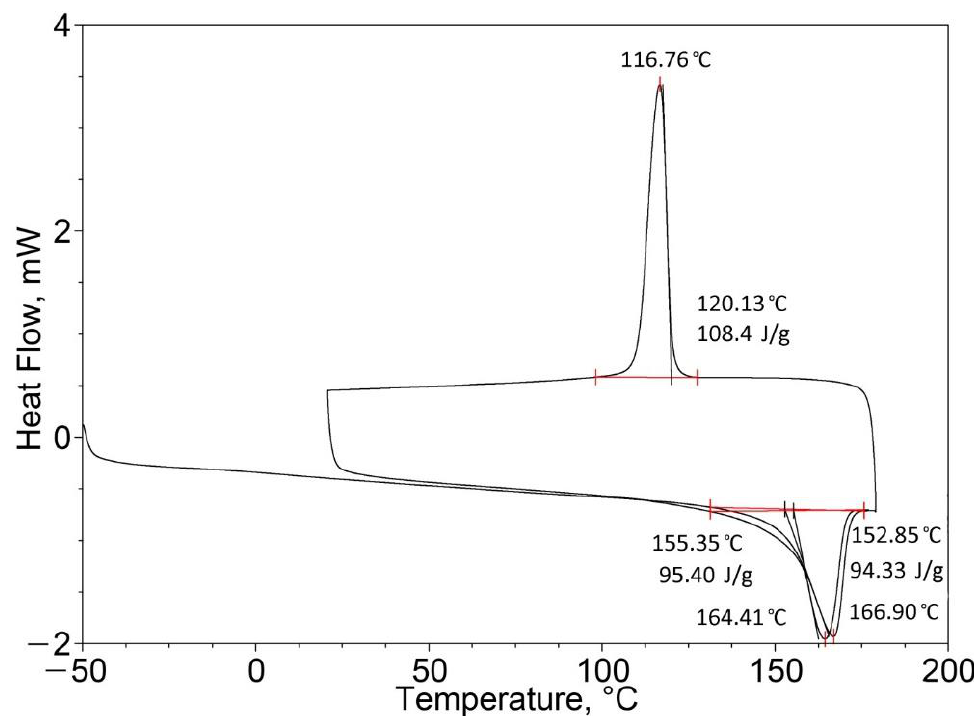
Figure 7. DSC scan curves (DSC thermograms, heat flow vs. temperature plot) and melting- crystallization-melting diagram of the initial pure PP-01030 polymer.